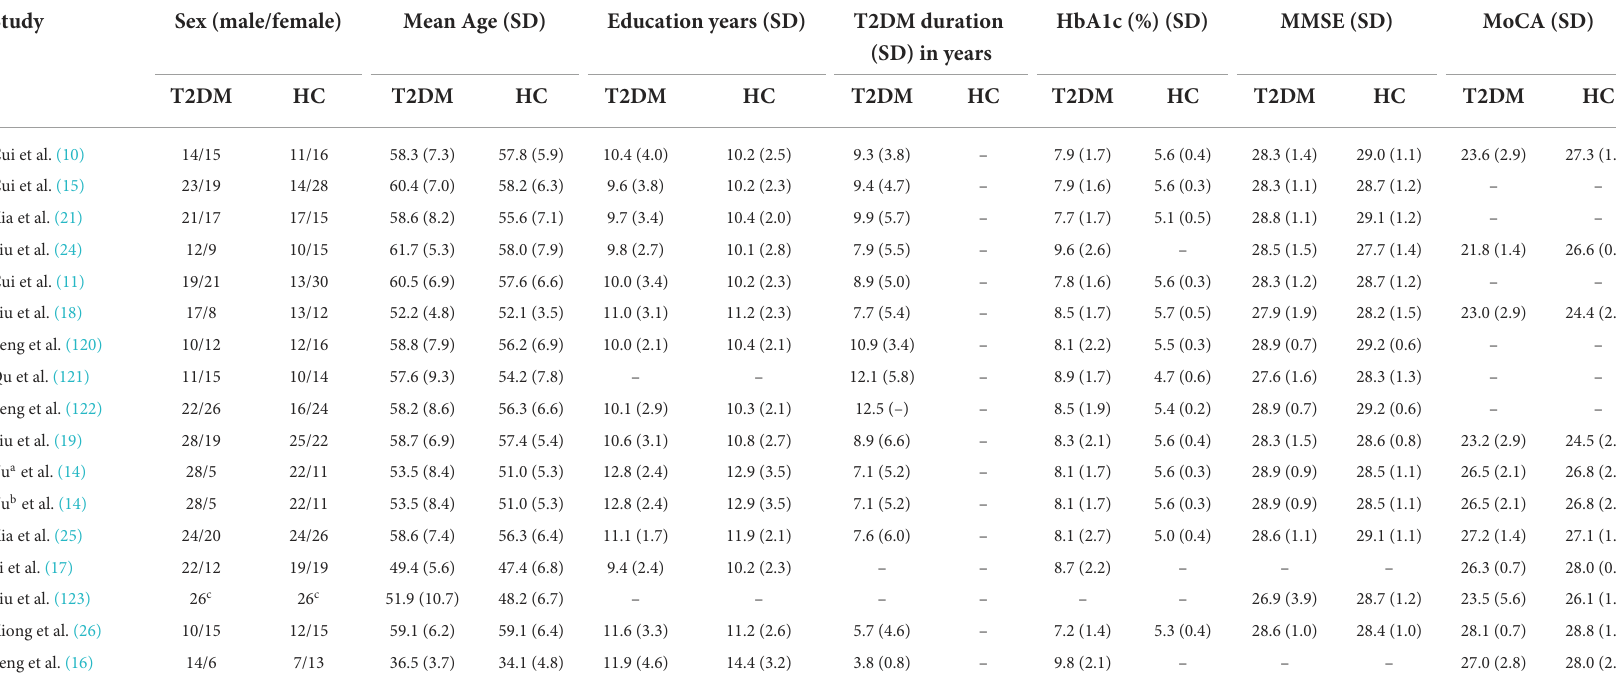
TABLE 1 Demographic, clinical, and cognitive characteristics of study patients and control subjects included in the meta-analysis (group 1). Study